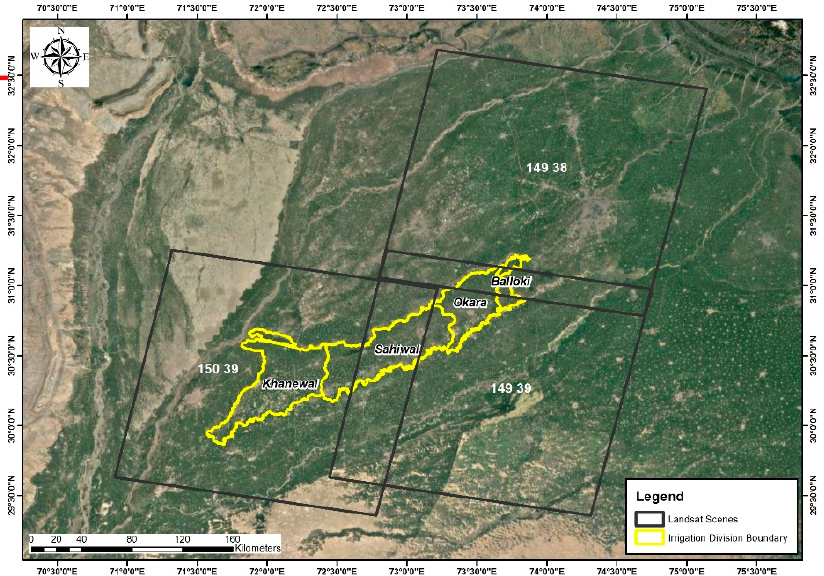
Figure 4. Landsat tiles coverage of the study area.